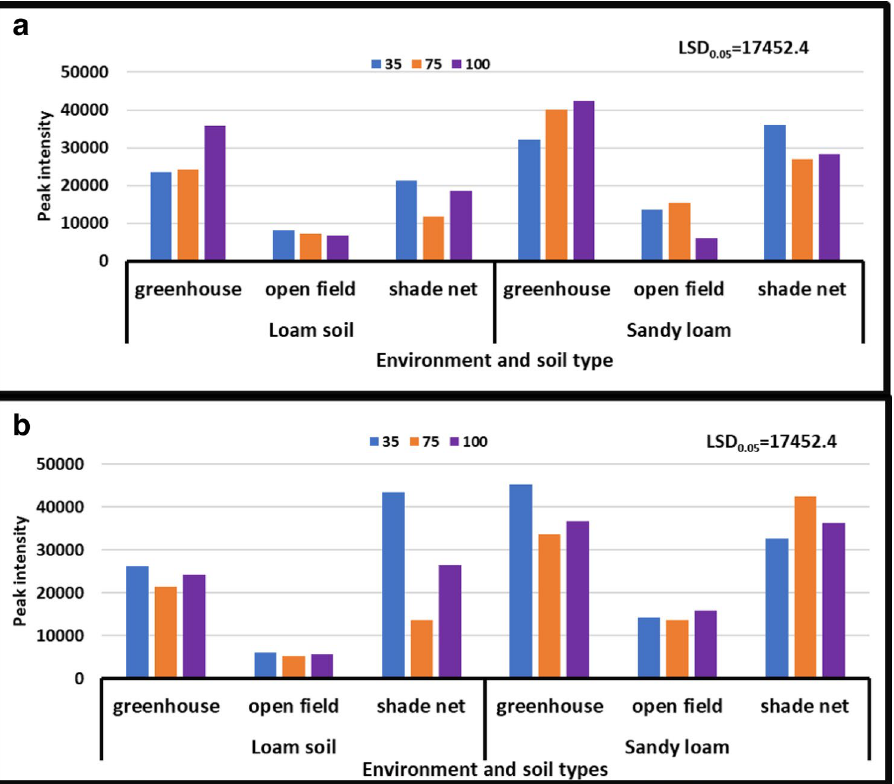
Figure 5. Treatment interaction effect on 5-glutamylcusteine of African horned cucumber fruit. 35 means severe water stress; 75 means moderate water stress; 100 means no water stress; ( a ) means treatment interaction of water stress levels and soil types at different growing environments during the 2017/18 season; ( b ) means treatment interaction of irrigation water regimes and soil types at different growing environments during the 2018/19 season. Values are average over treatment. Peak intensity showing LCMS-8040 triple quadrupole mass spectrometer intensities which represent the quantity of metabolites varying with treatments. LSD 0.05 is the least significant difference of